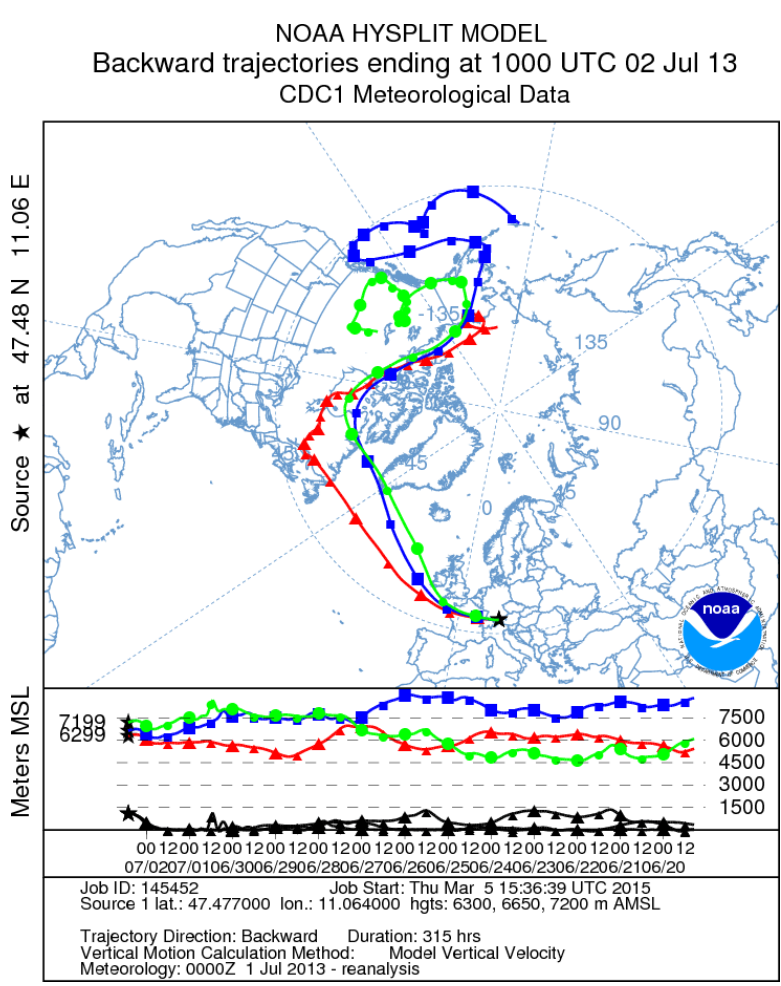
Figure 7. HYSPLIT backward trajectories initiated above Garmisch-Partenkirchen on 2 July at 11:00CET (10:00UTC) within the altitude range of the mid-tropospheric aerosol layer in Fig. 5; the trajectories pass over the north coast of continental Canada at rather high altitudes, overlapping with fire regions just above